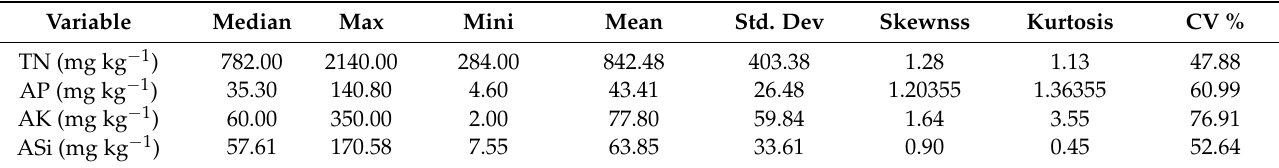
Table 1. Descriptive statistics of N, P, K and Si in soils.